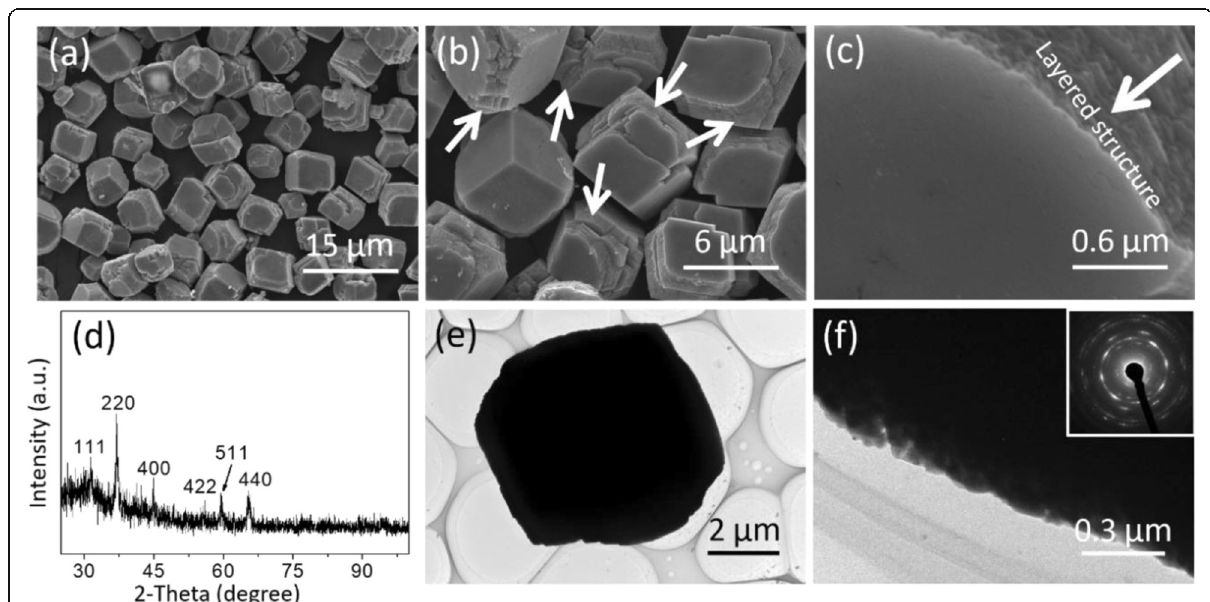
Fig. 1 a – c SEM images, d XRD pattern, and e , f TEM images of porous Co 3 O 4 quasi-cubes with the SAED pattern in the inset of ( f